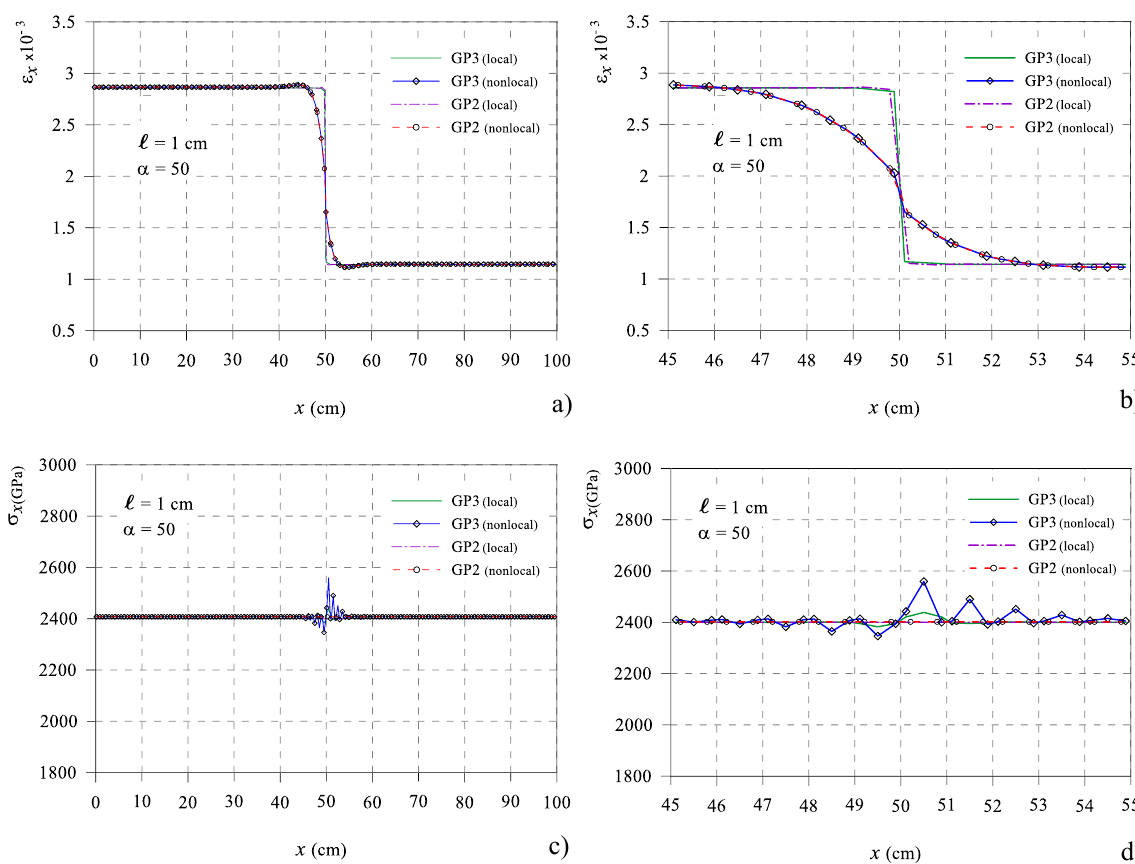
Figure 4: Local and nonlocal solution obtained with full (GP3 curves) and reduced (GP2 curves) integration for the bar of Figure 1 with inter- nal length ℓ = 1 : a ) and b ) strain ε and zoom at the bar mid zone respectively; c ) and d ) stress σ x tively.